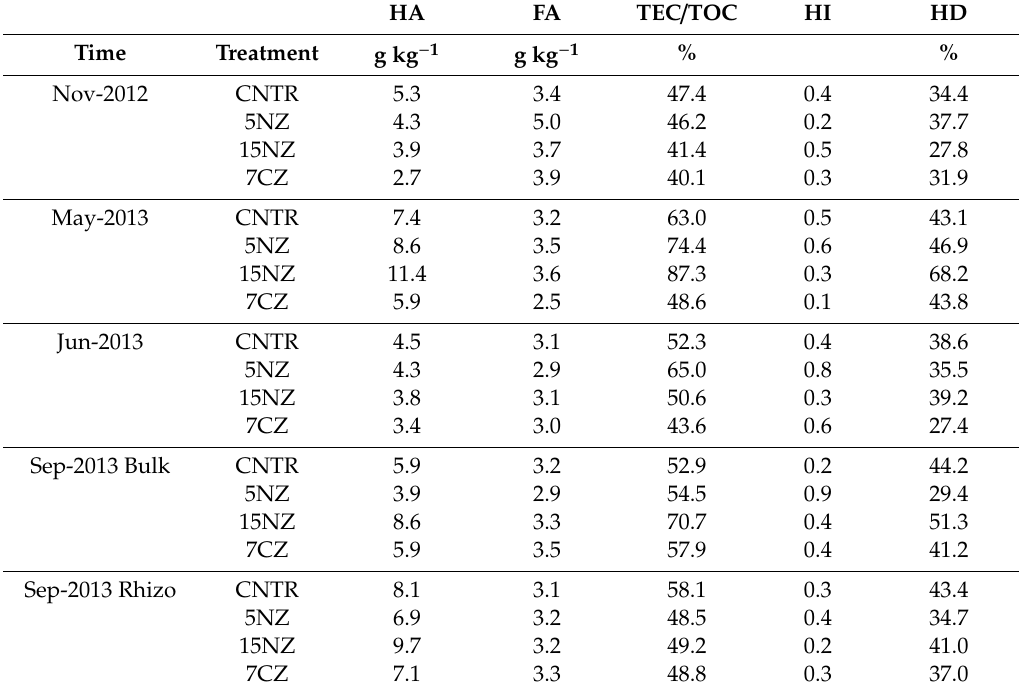
Table 3. C content of Humic Acids (HA) and Fulvic Acids (FA), percentage of Total Extractable and Total Organic Carbon (TEC / TOC) ratio, Humification Index (HI) and Humification Degree (HD) according to Ciavatta et al. [33] and Sequi et al.